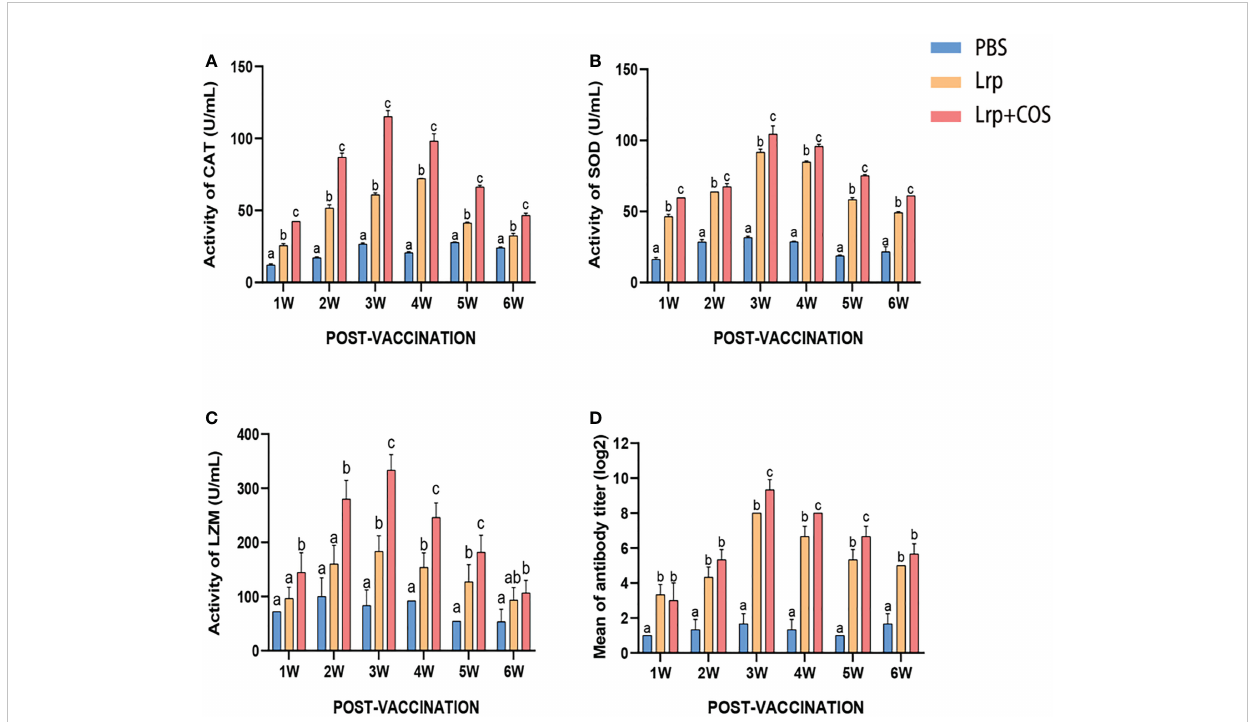
FIGURE 5 Determination of serum nonspeci fi c immune index and IgM titer of speci fi c antibody. (A) Detection of CAT activity in serum post-vaccination. (B) Detection of SOD activity in serum post-vaccination. (C) Detection of LZM activity in serum post-vaccination. (D) Detection of the IgM titer in serum post-vaccination by ELISA. Bars represented the mean relative expression (n=3) and error bars represented standard errors. Signi fi cant differences ( p <0.05 ) were marked by a,b and